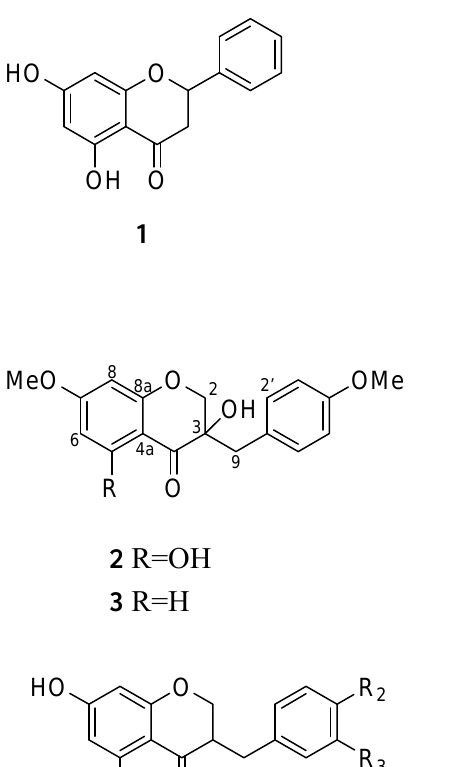
Figure 1. Chemical structure of compound